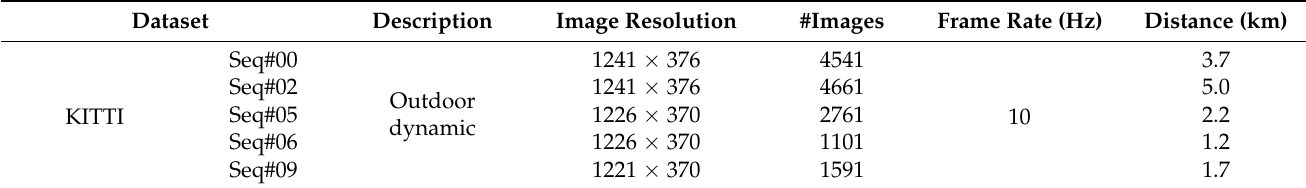
Table 1. Descriptions of the used